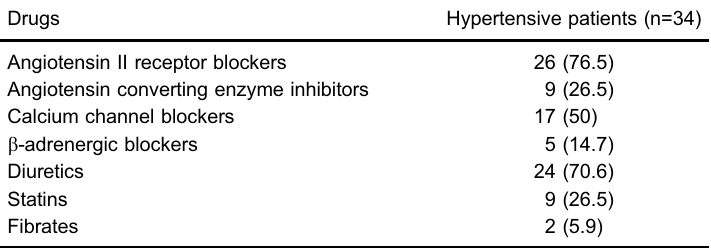
Table 2. Antihypertensive and cardiovascular drugs used by hypertensive